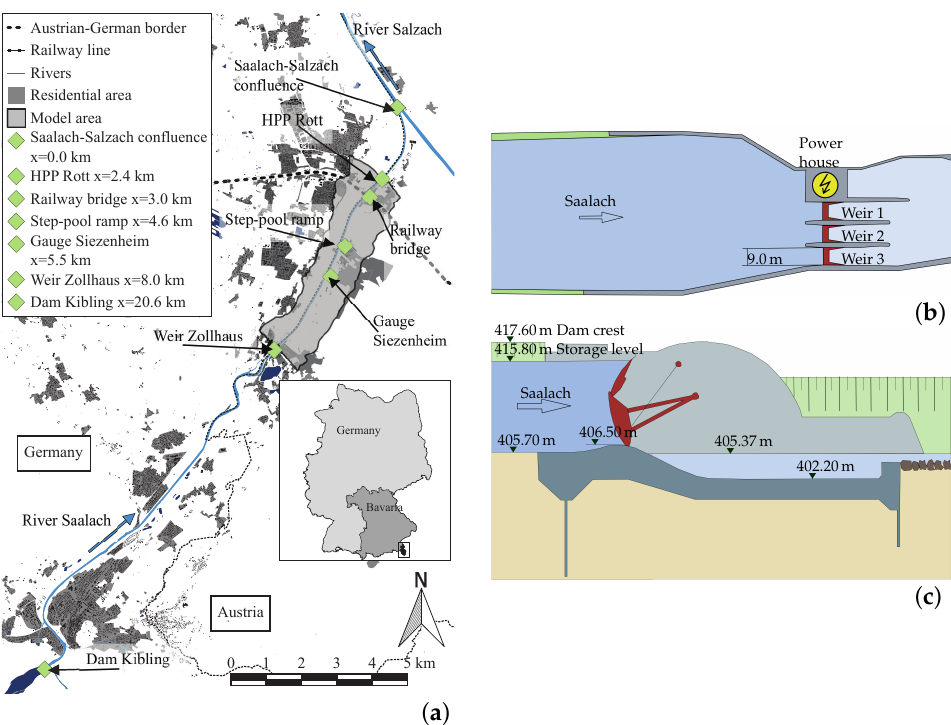
Figure 2. ( a ) Overview of the study site, including the extent of the numerical model and the important sites along the river [37]; and sketches of the HPP Rott in top ( b ) and longitudinal sectional ( c ) views [9]. Table 2. Main model parameters of the 2D hydromorphological model.